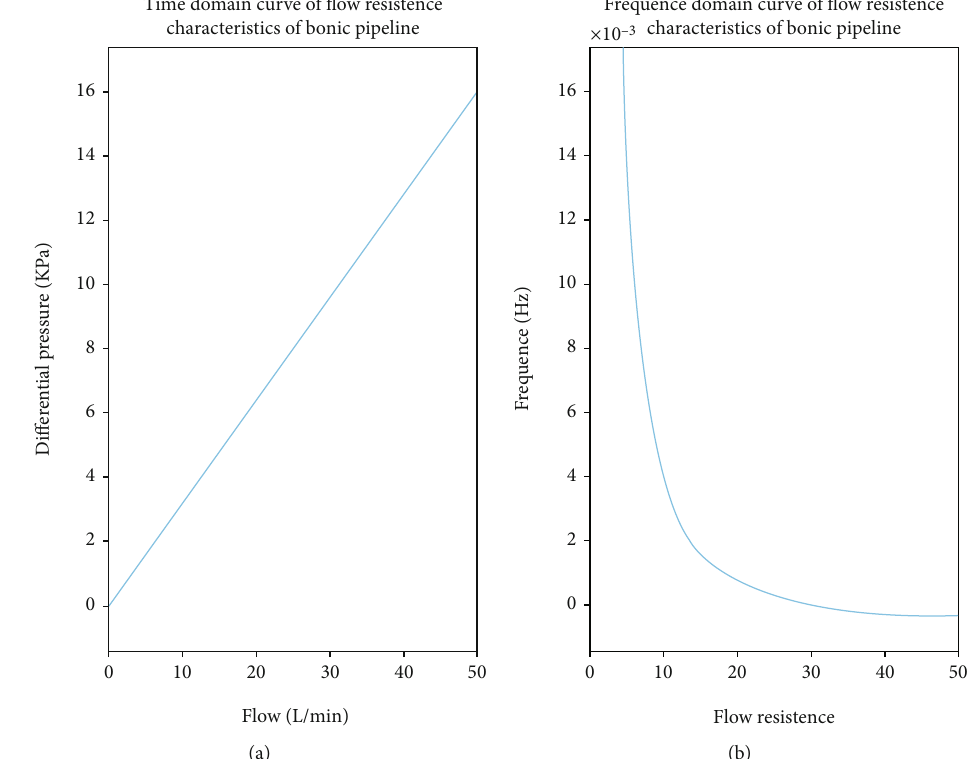
Figure 14: Flow resistance characteristic curve of bionic pipeline. (a) Bionic pipeline fl ow resistance characteristic curve in time domain. (b) Flow resistance characteristic curve of bionic pipeline in frequency